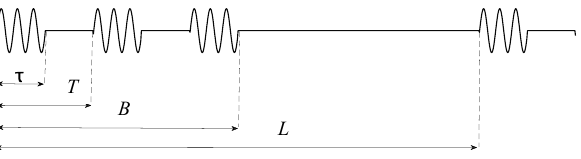
Fig. 1. Illustration of waveform